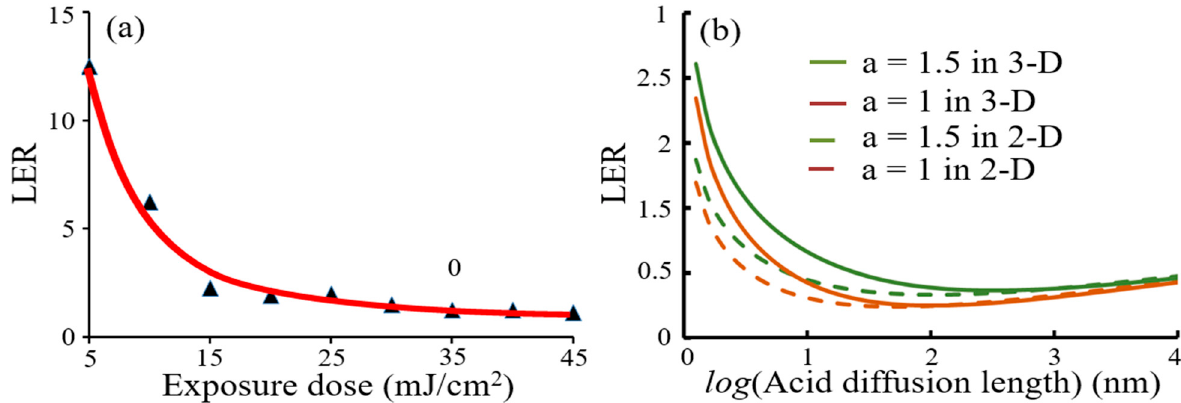
Figure 6. LER simulation results: ( a ) LER dependency of exposure dose; ( b ) prediction of LER trends for 5-nm patterns using two values of the deblocking reaction capture range, 𝑎 = 1.0-nm and 1.5-nm in 2-Dimension and 3-Dimension calculations.